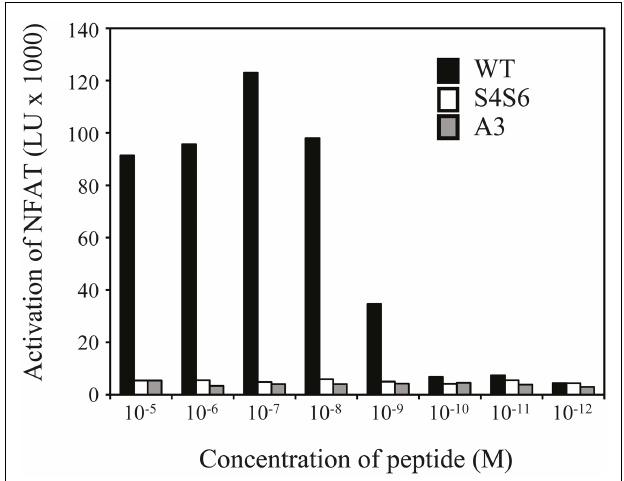
FIGURE 5 |The gp100APL S4S6 is not able to induce activation of NFAT .TCR-engineered JurkatT cells were transfected with NFAT reporter and β -galactosidase constructs and subsequently co-cultured withT2 target cells that were either non-loaded or loaded with titrated amounts of gp100 wt peptide (wt) or APLs A3 and S4S6 (range: 10 − 5 –10 − 12 M peptide). Following a 6h co-cultivation at an effector to target cell ratio of 2:1, lysates were collected and measured for luciferase activities [depicted as light units (LU) corrected for medium only]. Results of one (out of two) representative experiment are shown based on the mean value of triplicate data points.